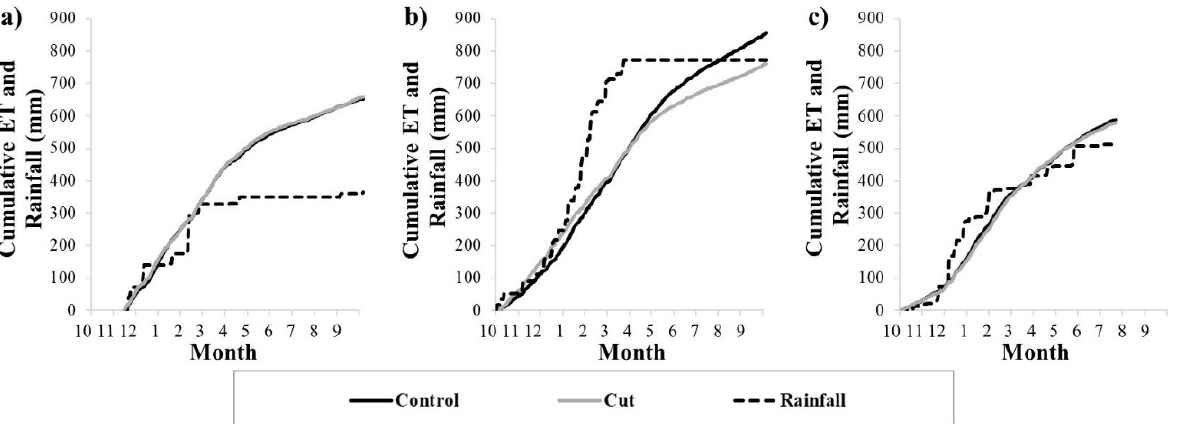
Figure 9 . The cumulative ET at the control and cut plots and rainfall for the ( a ) 2019–2020, ( b ) 2020– 2021 and ( c ) 2021–2022 hydrological years.